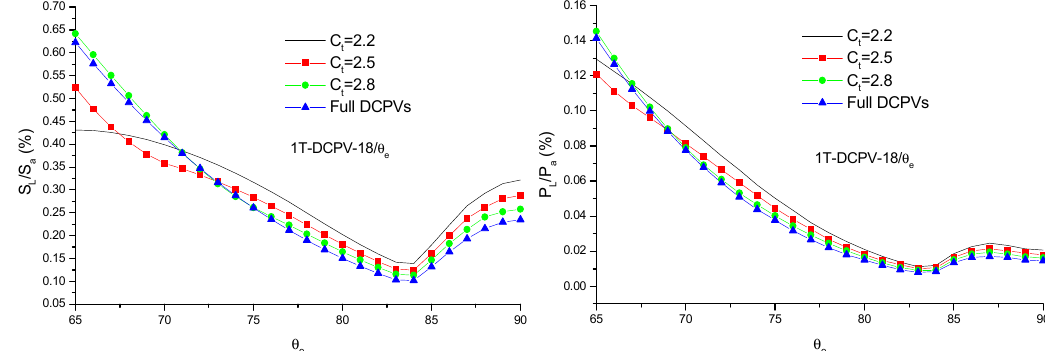
Figure 16 . Effects of Figure 16. Effects of θ e on annual radiation and power losses of 1T-DCPV-18/ θ e due to leakage.